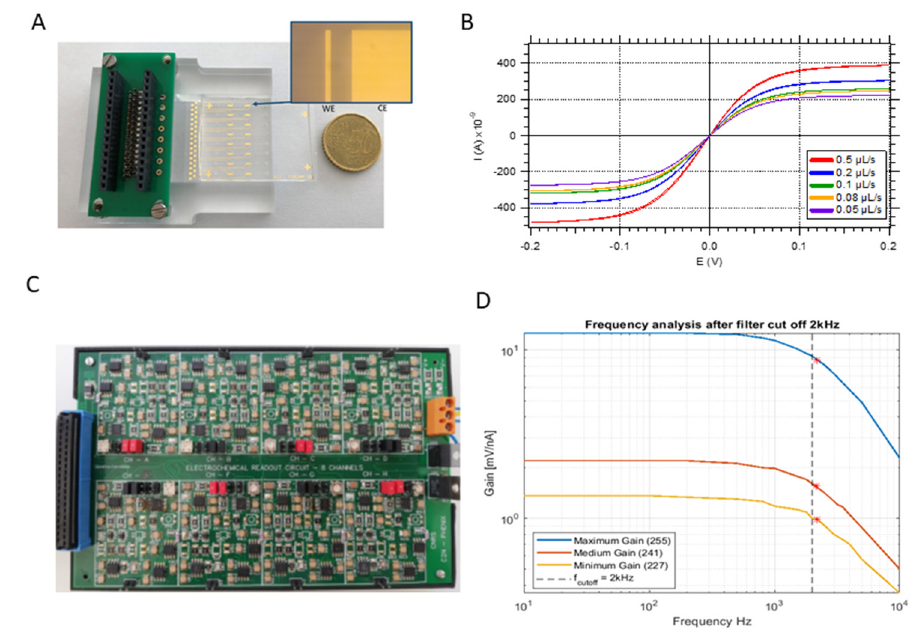
Figure 3. ( A ) . Figure representing the final microfluidic device on the chip holder. A zoom on the embedded electrochemical cell is reported. ( B ). Characterization response of the embedded electro- chemical cells (using a BioLogic VSP 300) at different flow rates after its fabrication. ( C ). Dedicated electronic circuit developed for the multiplexed readout of up to 8 different sensors. ( D ). Frequency response characterization of the analog stage comprising the current − voltage conversion, amplification and filtering for different values of gain: maximum gain (blue), medium gain (red) and minimum gain (yellow). The dotted vertical line represents the theoretical cut off frequency, and the red stars the found cut off frequency for each measurement.